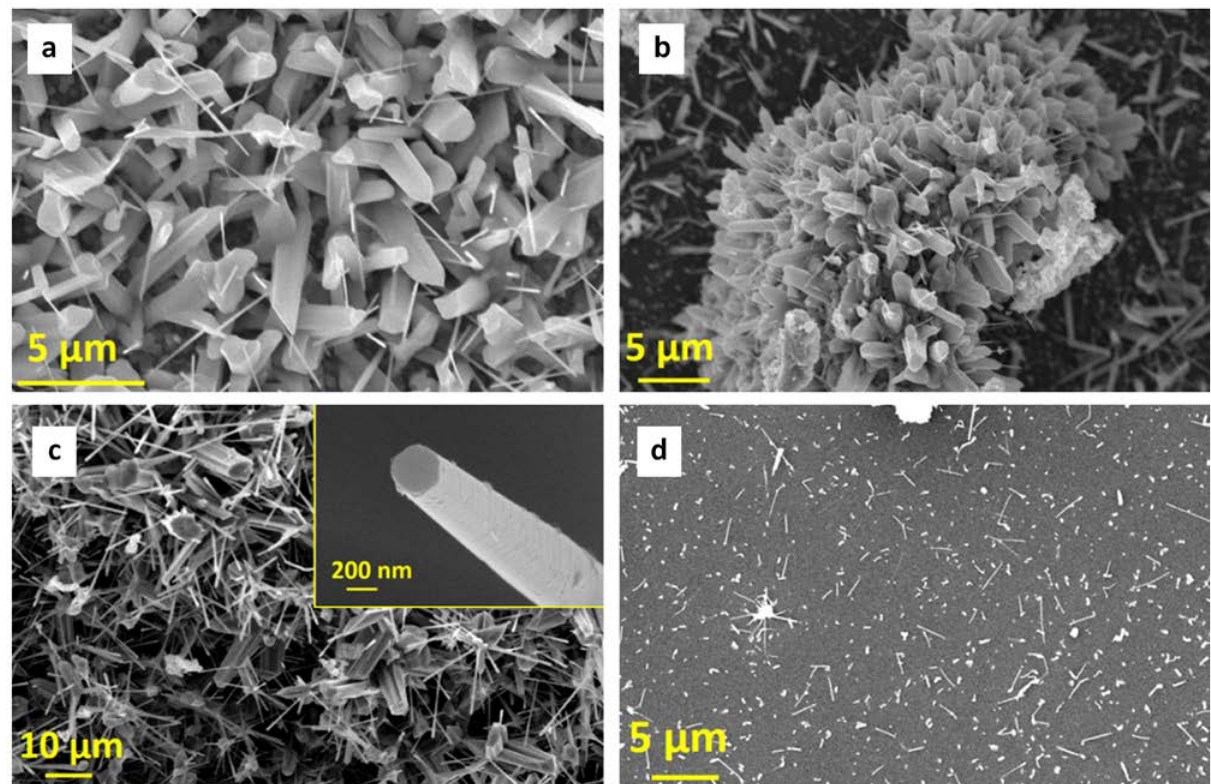
Figure 2. SEM micrograph of sample C-Mg at different zone and magnification. NWs growth starting from ( a , b ) shaft- shaped and (c) leaf-shaped microstructures; (d) NWs developing from a flat surface.The inset of panel c shows the hexagonal flat top of a NW.